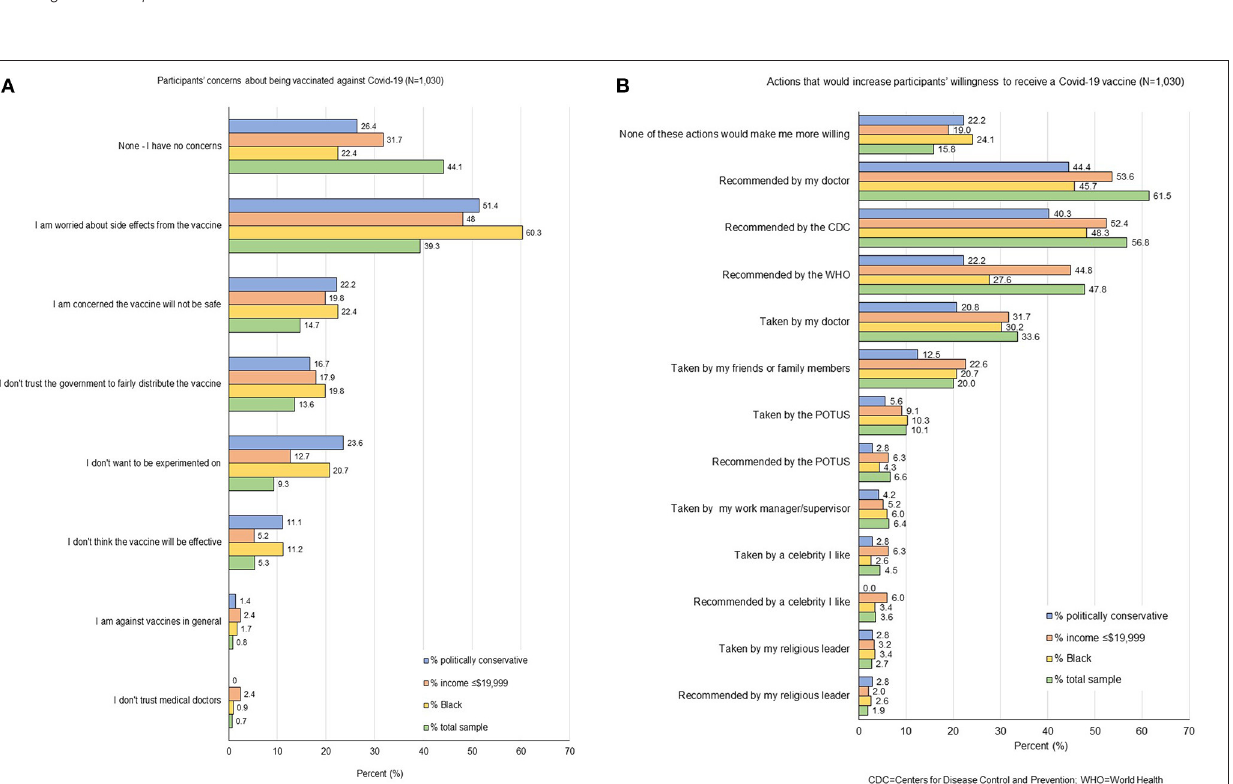
Frontiers in Medicine |